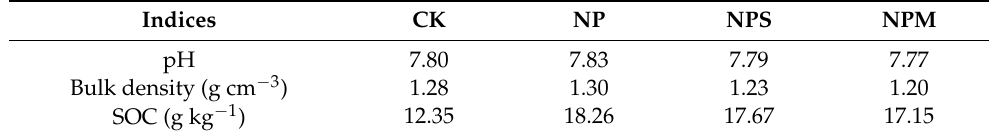
Table 1. Soil physical and chemical properties for CK, NP, NPS, and NPM treatments in 0 − 15 cm layer in